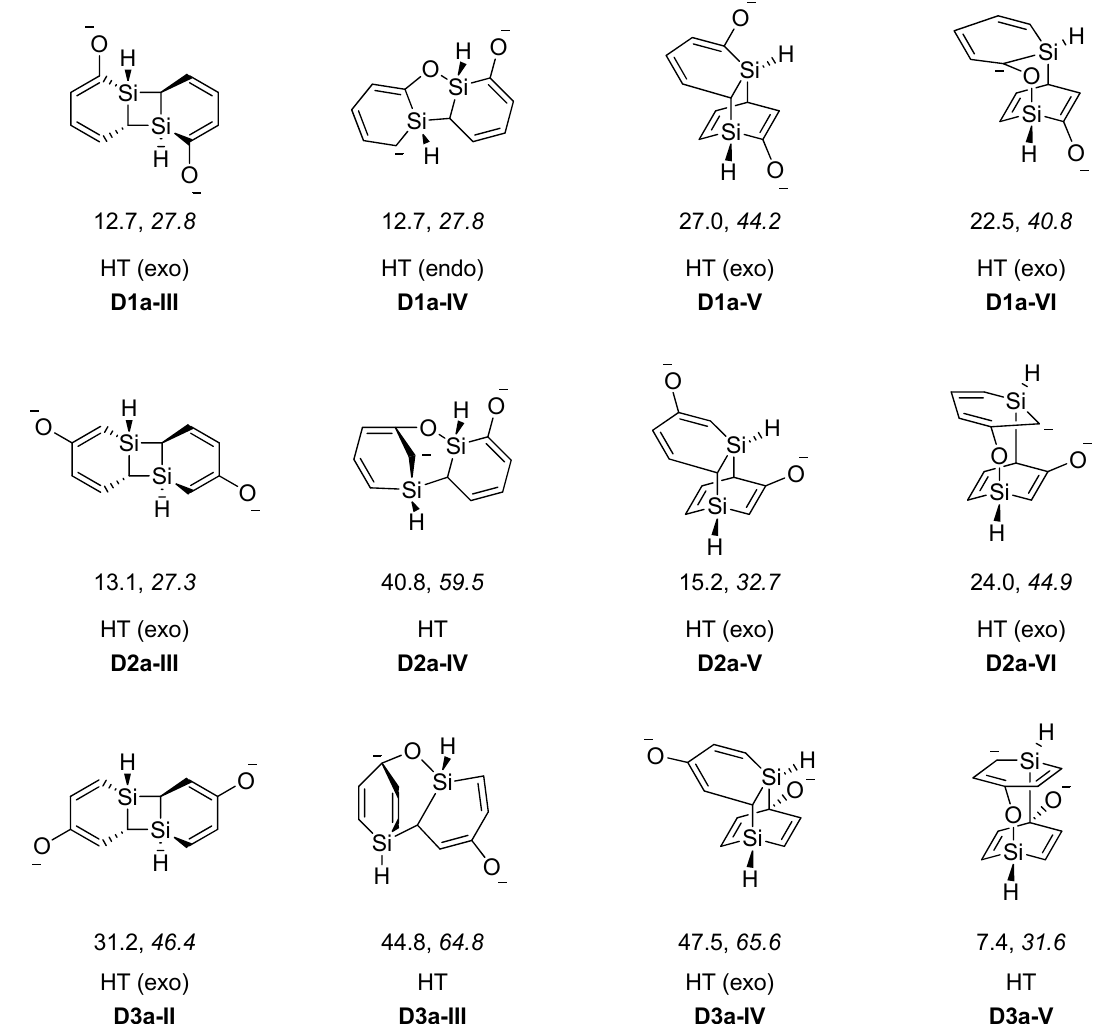
Figure 4. Low-energy [2+2], [4+2] and other dimers of silaphenolates ( 1a – 3a ) calculated at the M062X/6-311G(d)//M062X/6-31G(d) (normal) and B3LYP/6-31G(d) (italics) levels. Dimerization energies in kcal/mol. From left to right the dimers are; [2+2], [2+3], [4+2], and [4+3] cycloadducts, where the [2+2] and [4+2] cycloadducts involve only Si-C bond formation whereas the [2+3] and [4+3] cycloadducts involve also Si–O bond formation.